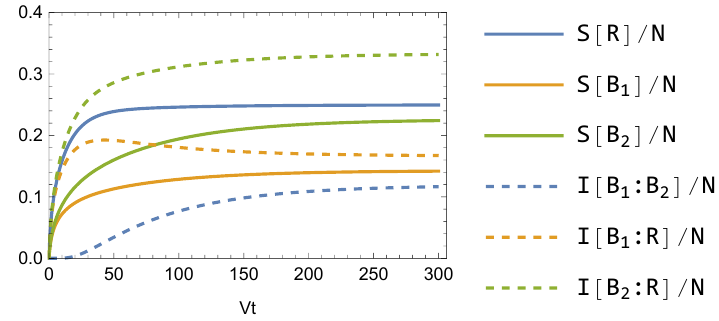
Figure 16 . The evolution on entropy and mutual information in the EPR clusters, where M = 16 , N = 5 , n = 1 , N = 10 and V = Λ = 1 1 R M